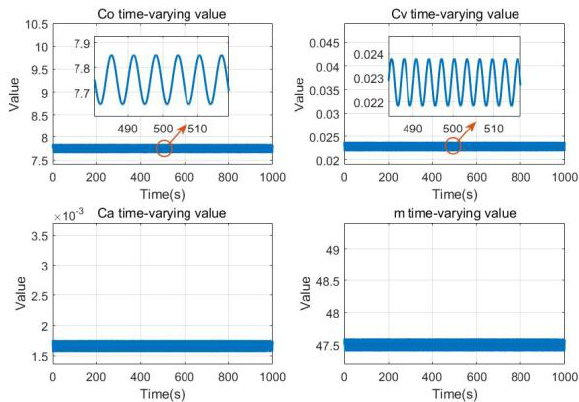
Figure 12. Change of time-varying coefficients.